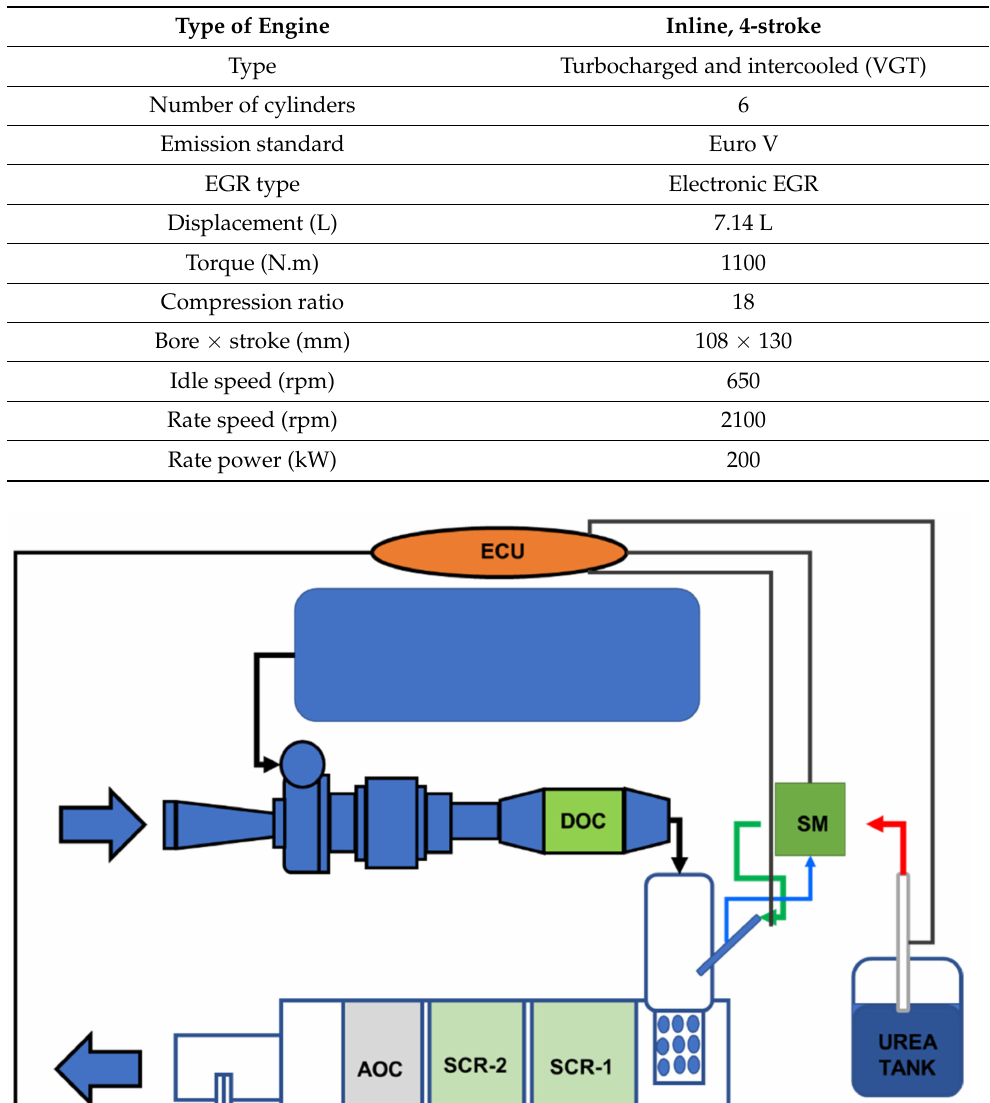
Table 9. The engine specifications, adapted from Bai et al. [114].